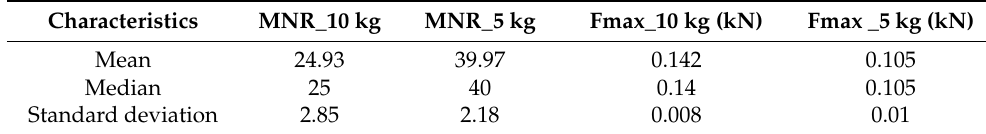
Table 1. Descriptive statistics of MNR and maximum forces.